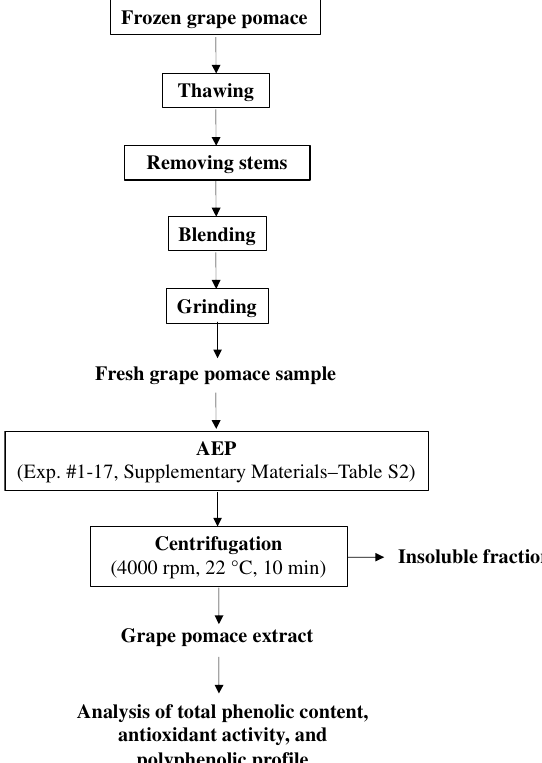
Figure 1. Process flow diagram for the single-stage AEP experiments evaluating the effect of pH (2.64–9.36), SLR (1:50.0–1:5.0), and temperature (41.6–58.4 °C) on grape pomace phenolic extraction.